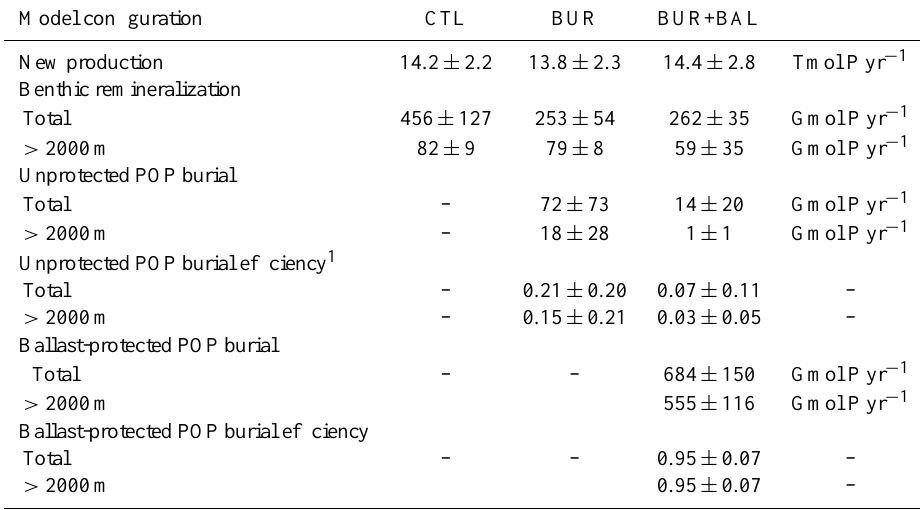
Table 2. Rate of P production, benthic remineralization, and burial from the three different P cycle models considered here. Model